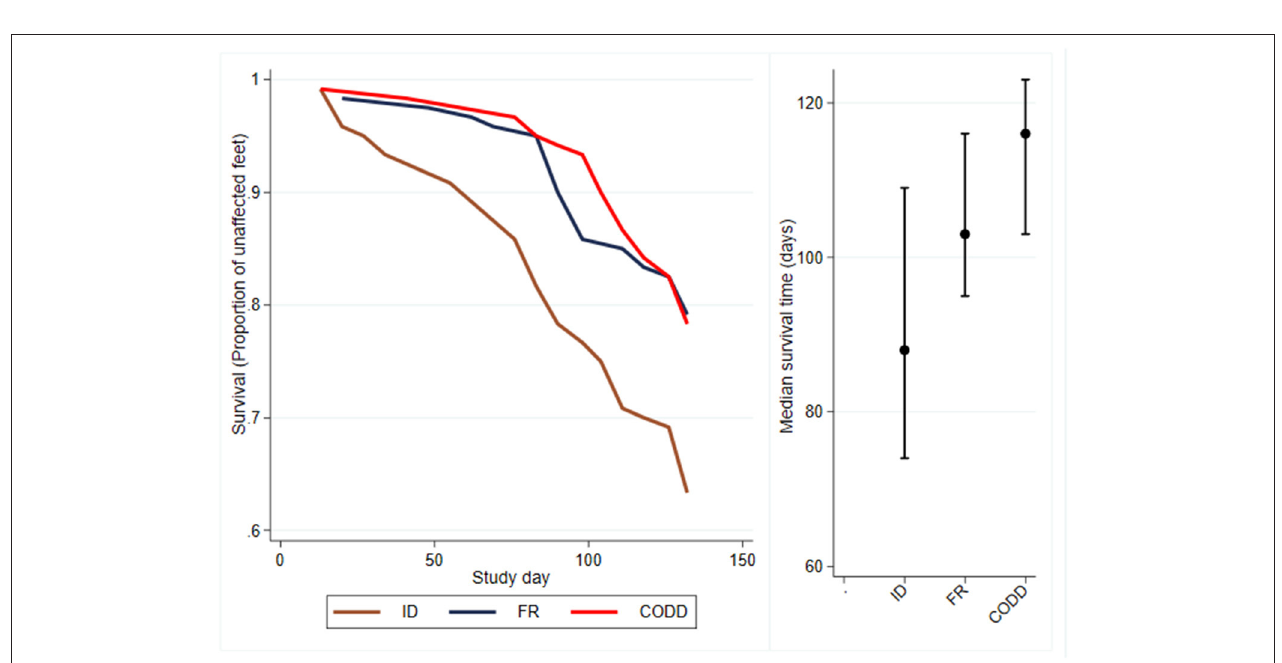
FIGURE 4 | Kaplan–Meier survival curves and median times to first observation of a clinical lesion for the experimental sheep ( n = 30 sheep, n = 120 feet).